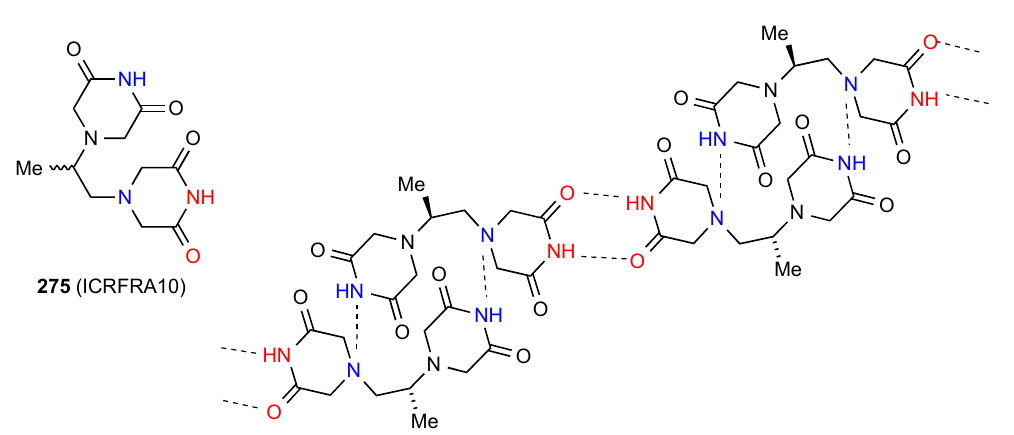
Figure 77. Structure adopted by compound 275.